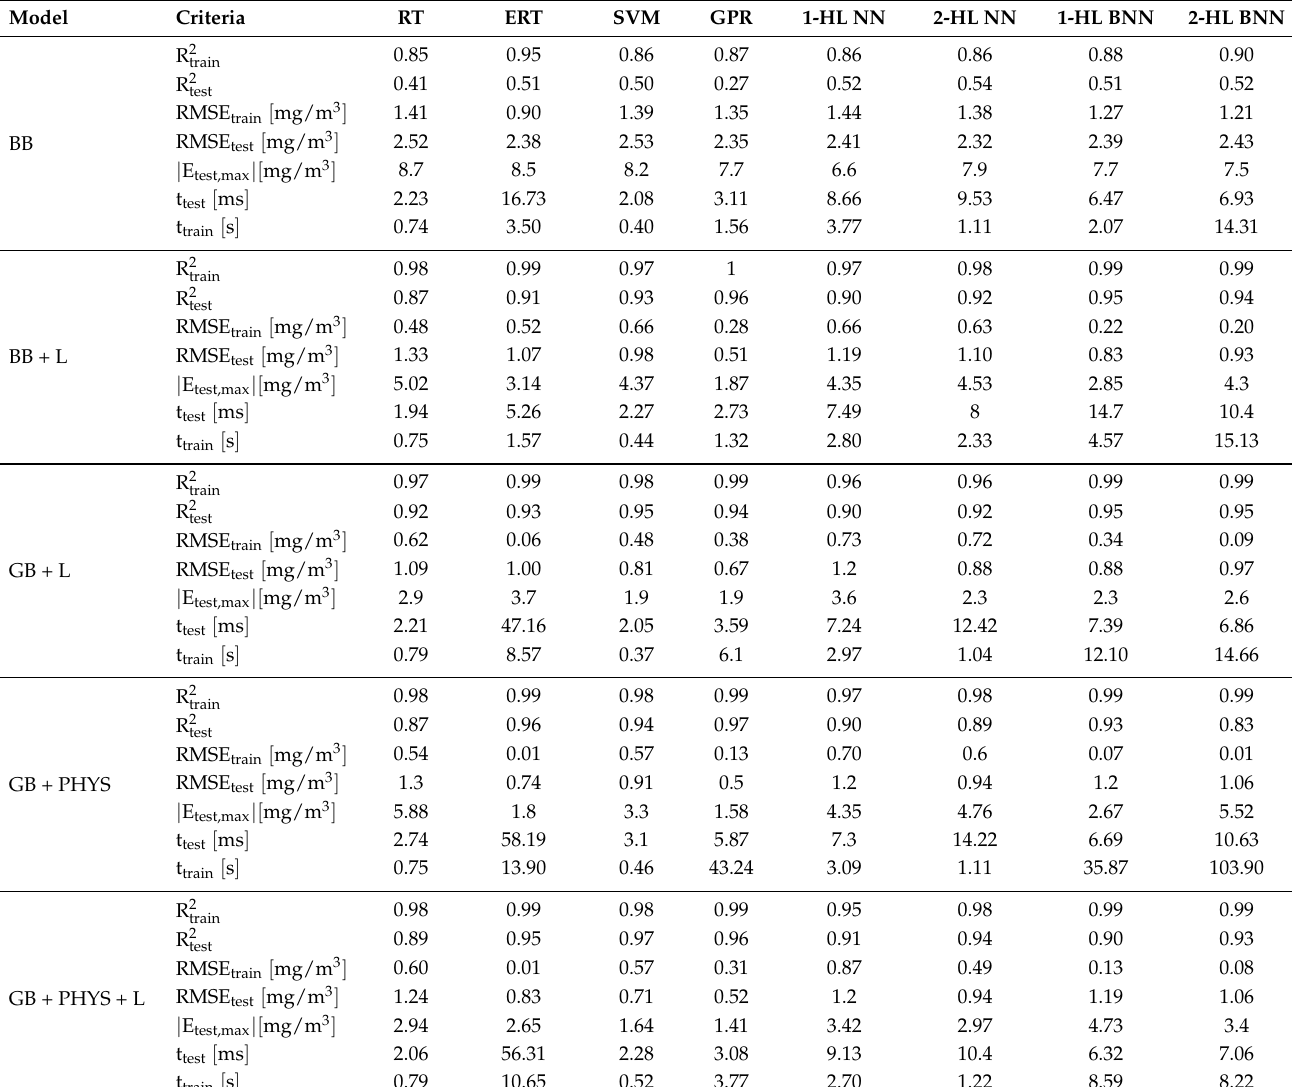
Table 4. ML-based data-driven soot models comparison. BB, L, GB, and PHYS stand for black-box, LASSO, grey-box, and physical insight,